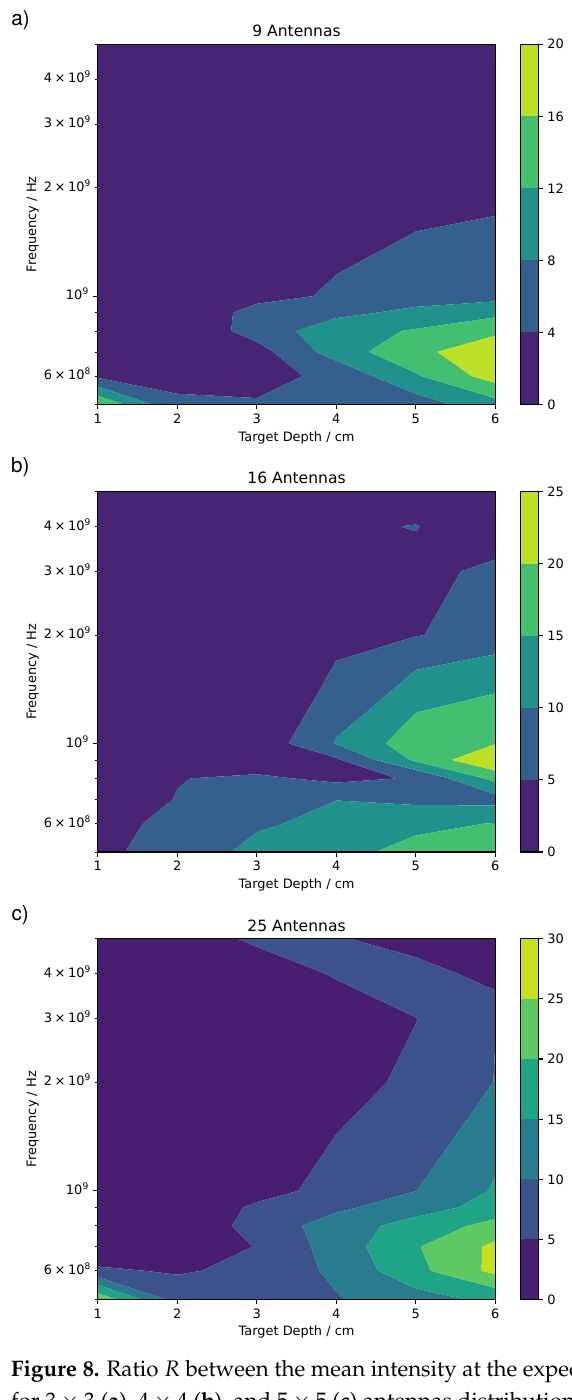
Figure 8. Ratio R between the mean intensity at the expected target position and the rest of the map for 3 × 3 ( a ), 4 × 4 ( b ), and 5 × 5 ( c ) antennas